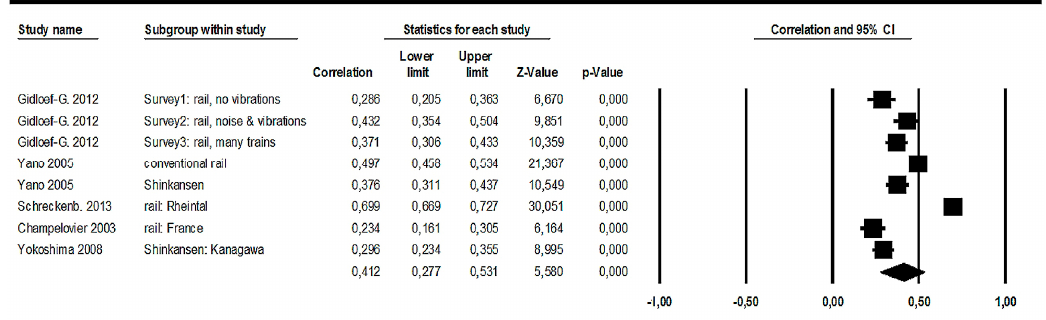
Figure 11. Meta ‐ analysis of eight studies using Pearson correlations between L Aeq,24h and railway noise annoyance raw scores. The right part of the graph contains a forest plot of the correlations and their respective 95% confidence intervals. The figures of the last row indicate the summary estimates.